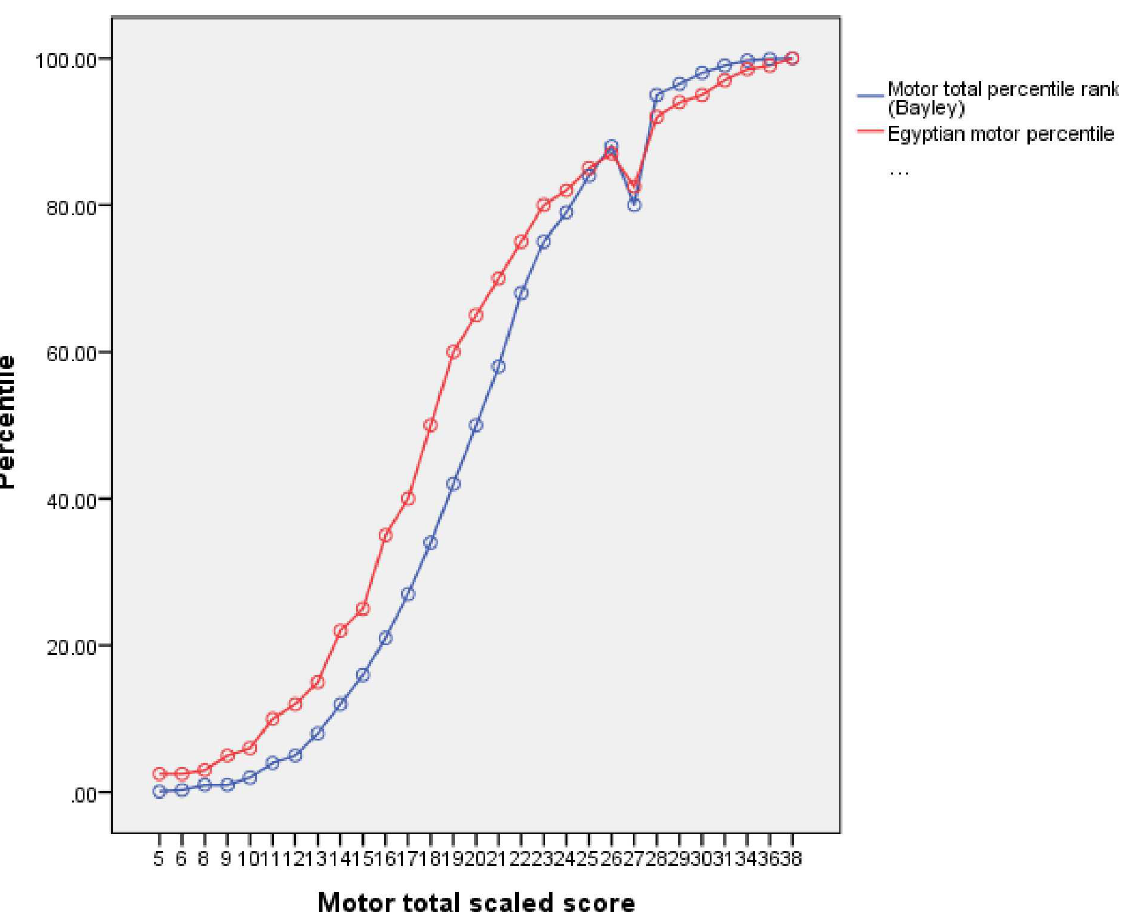
Fig 3. Egyptian versus American percentiles of the motor